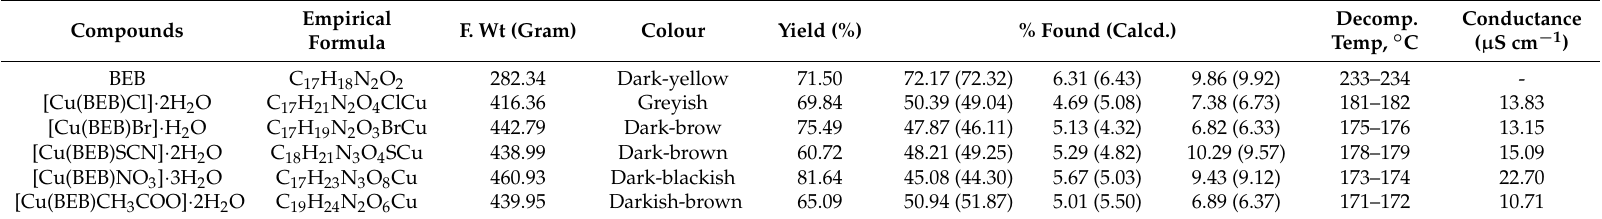
Table 1. Physicochemical and analytical data of [BEB] and its metal complexes.